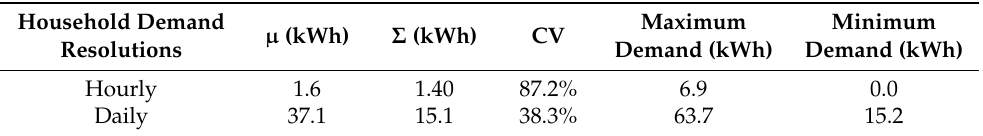
Table 4. Overall statistical data analysis forhousehold